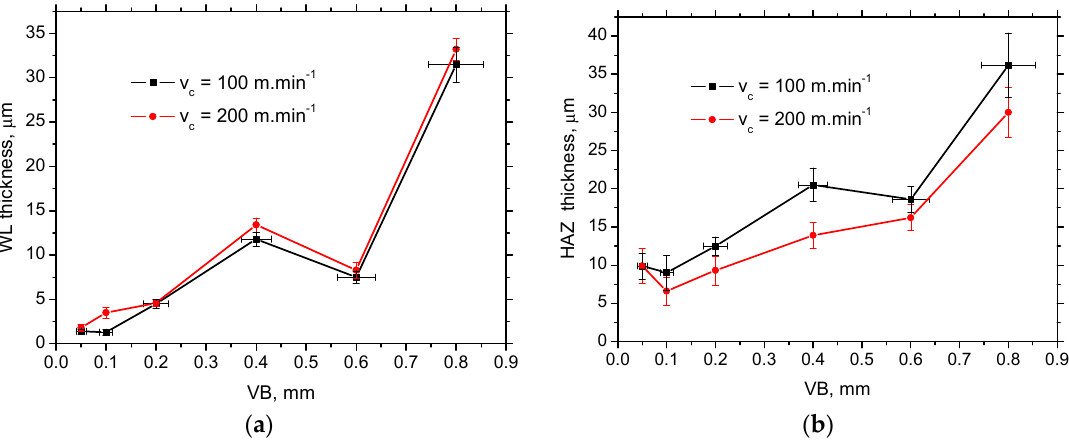
Figure 5. VB versus WL and HAZ thickness: ( a ) VB versus WL thickness; ( b ) VB versus HAZ thickness.